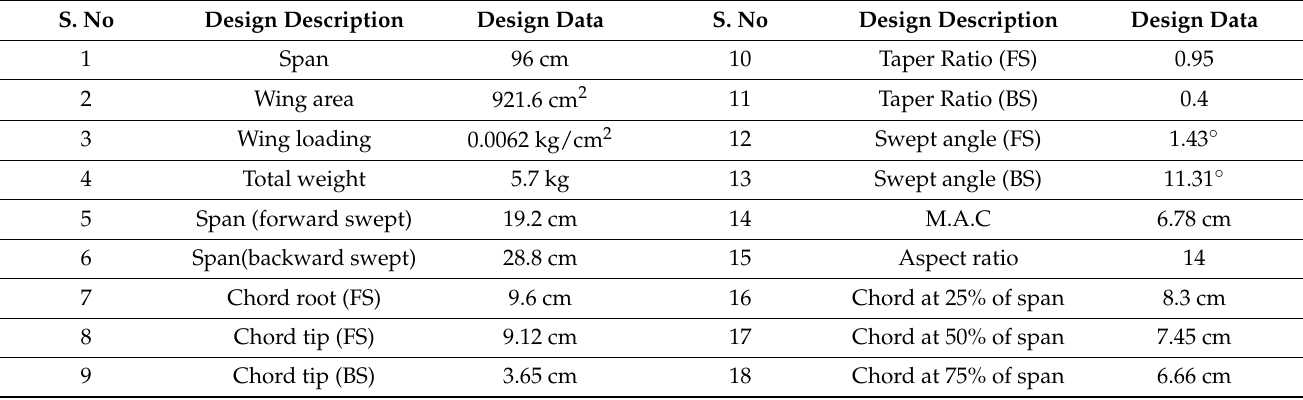
Figure 7. Conceptual design of nature inspired UAV. The estimated values for wing dimensions are tabulated in Table 10. Table 10. Final estimated data of